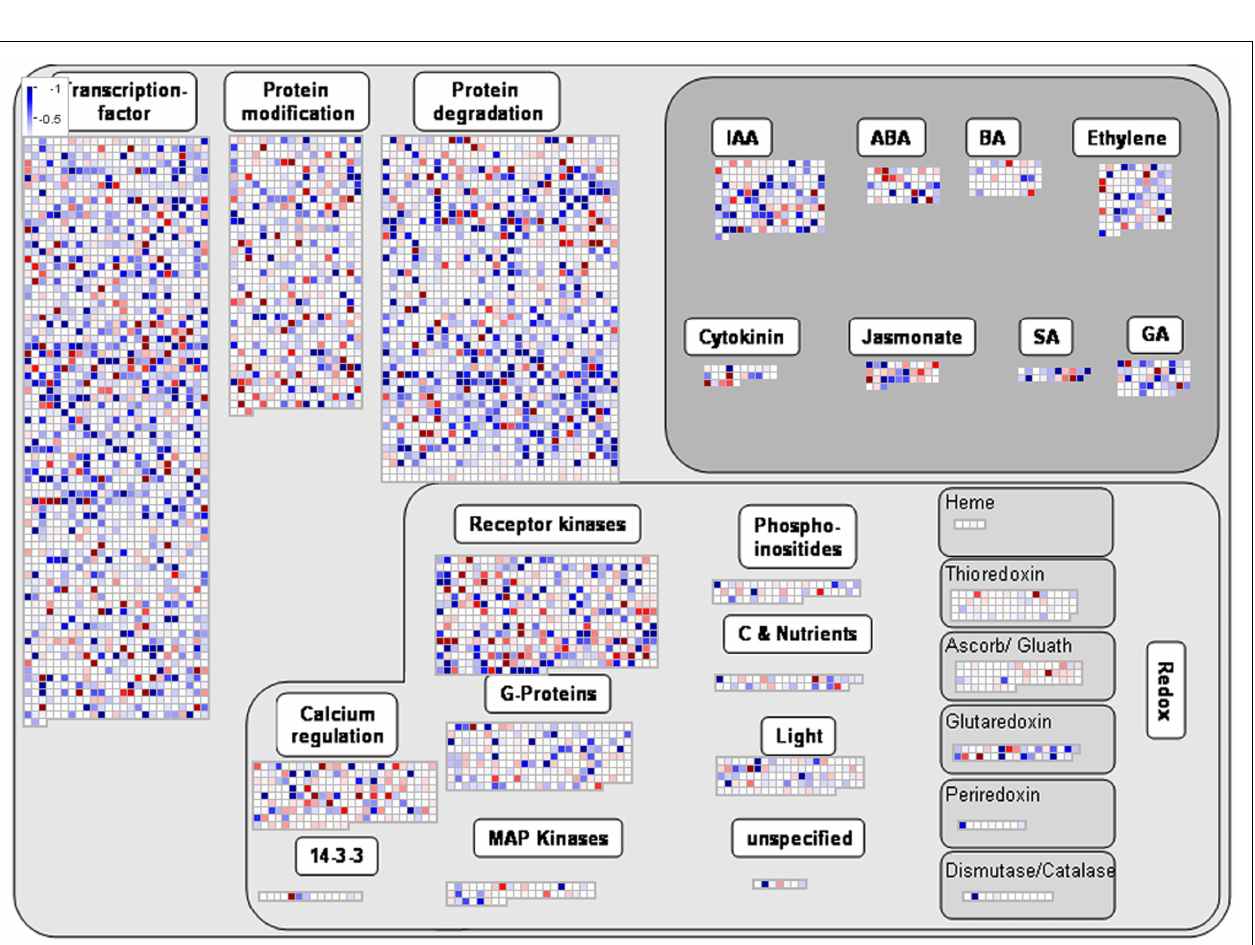
Frontiers in Plant Science | Plant